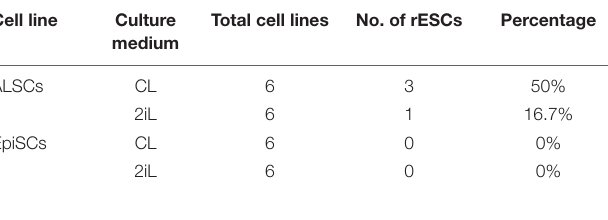
TABLE 2 | Efficiency of rESCs conversed from ALSCs and EpiSCs in CL and 2iL medium.